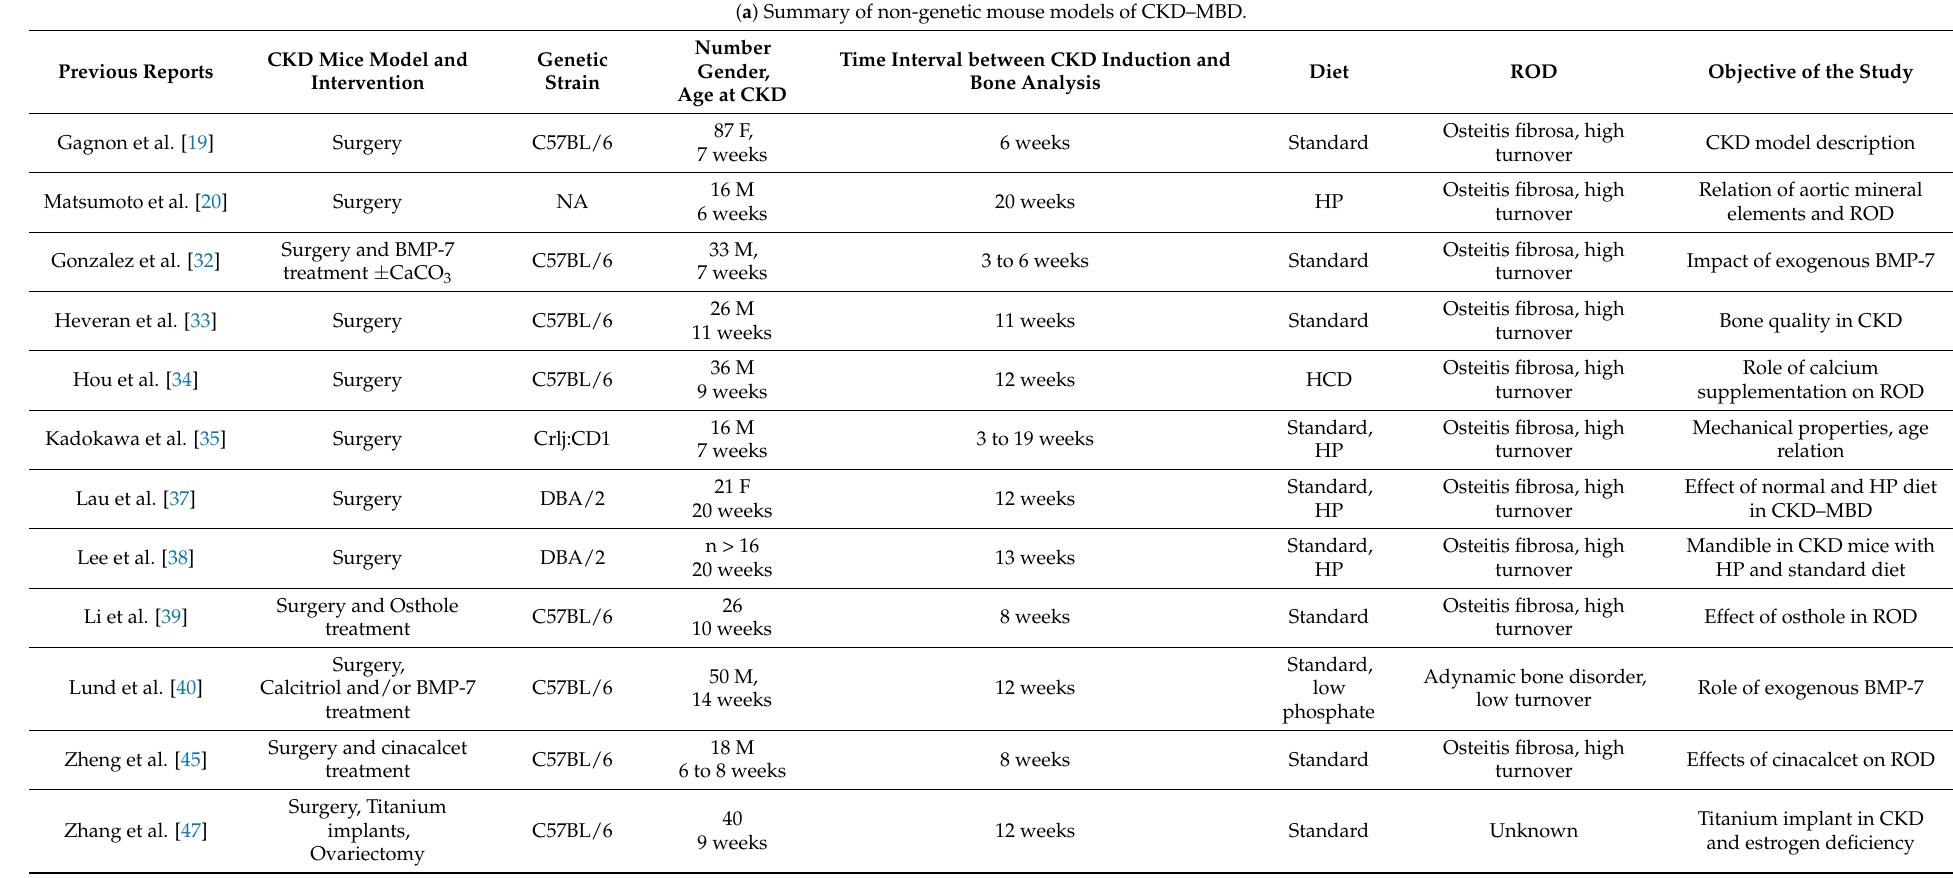
Table 1. Summary of non-genetic mouse models of CKD–MBD. ( a ) Summary of non-genetic mouse models of